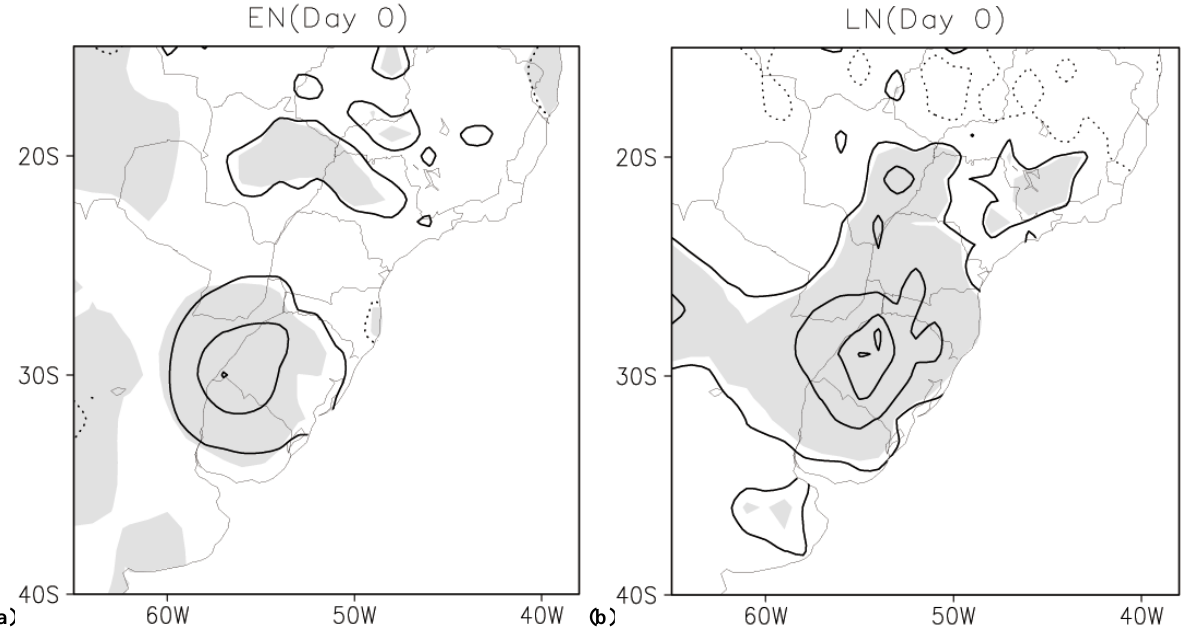
Fig. 3. Precipitation anomaly for DJF of SALLJ composites during their maximum intensity (day 0) for (a) EN and (b) LN years. Contour interval is 2mmday − 1 . Negative contours are dotted and the zero contours are omitted. Areas where the anomalies are statistically significant at the 95% level are shaded in